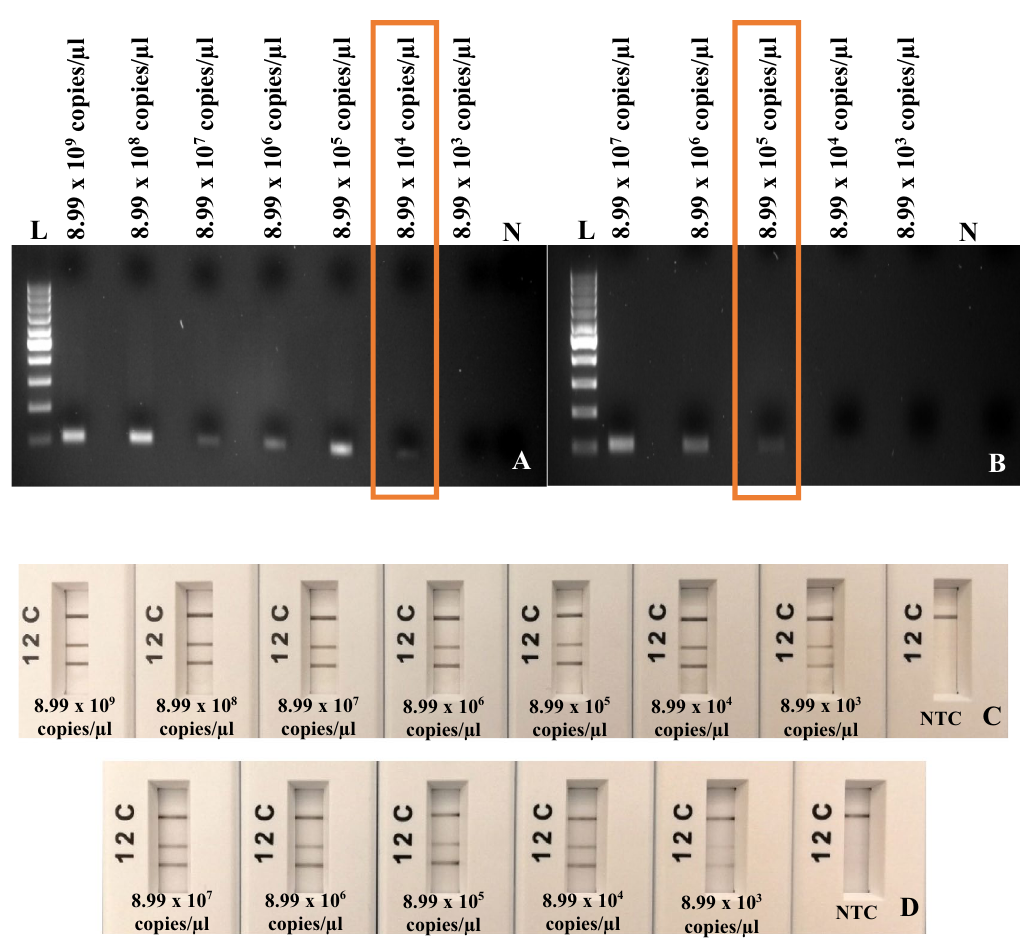
Figure 2. Limit of detection assays of A. marginale. ( A ) RPA-basic primers using ten-fold serial dilution of A. marginale plasmid from 8.99 × 10 9 to 8.99 × 10 3 copies/µl. ( B ) RPA-basic primers using Ten-fold serial dilution of A. marginale total DNA from 8.99 × 10 7 to 8.99 × 10 3 copies/µl. Lane N, non-template control (NTC, water); lane L, 100 bp DNA ladder. ( C ) Multiplex RPA- nfo primers and probe using ten-fold serial dilution of Artificial Positive Control (APC). ( D ) Multiplex RPA- nfo primers and probes using ten-fold serial dilution of A. marginale total DNA from 8.99 × 10 7 to 8.99 × 10 3 copies/µl. Lane C, flow-check line; Lane 2, detects FAM/Biotin